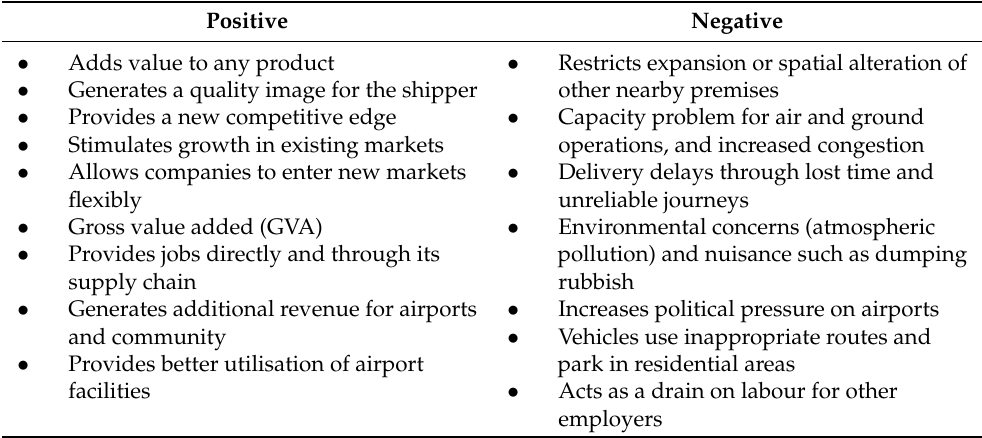
Table 1. Breakdown of implications of the air cargo industry (Source: The authors based on review of